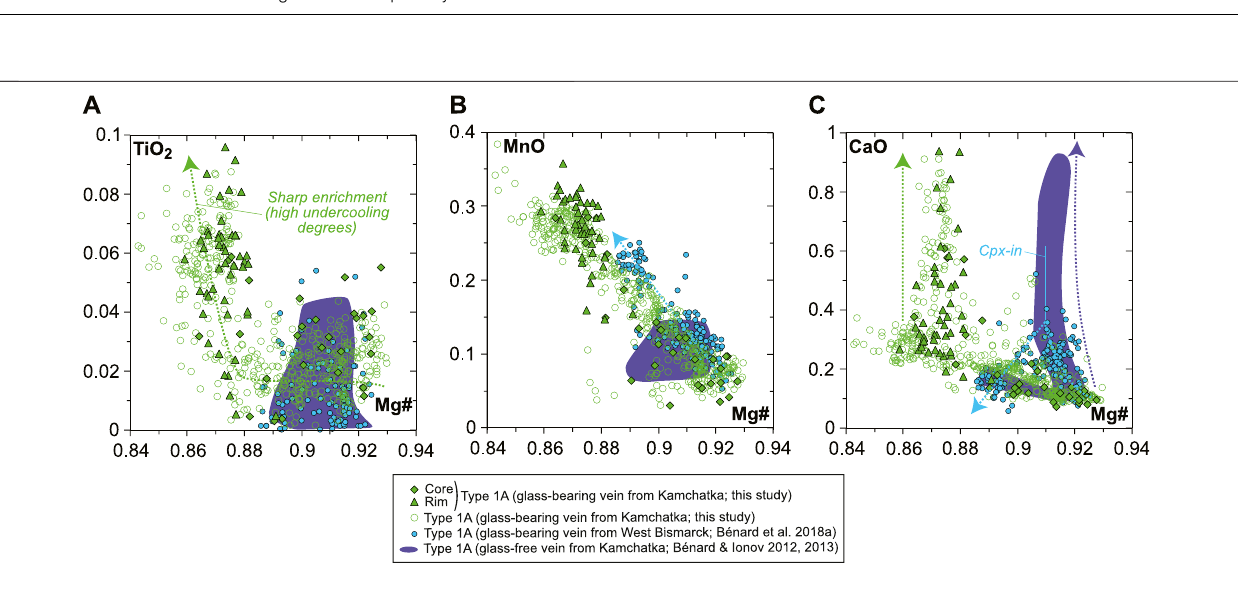
Frontiers in Earth Science |